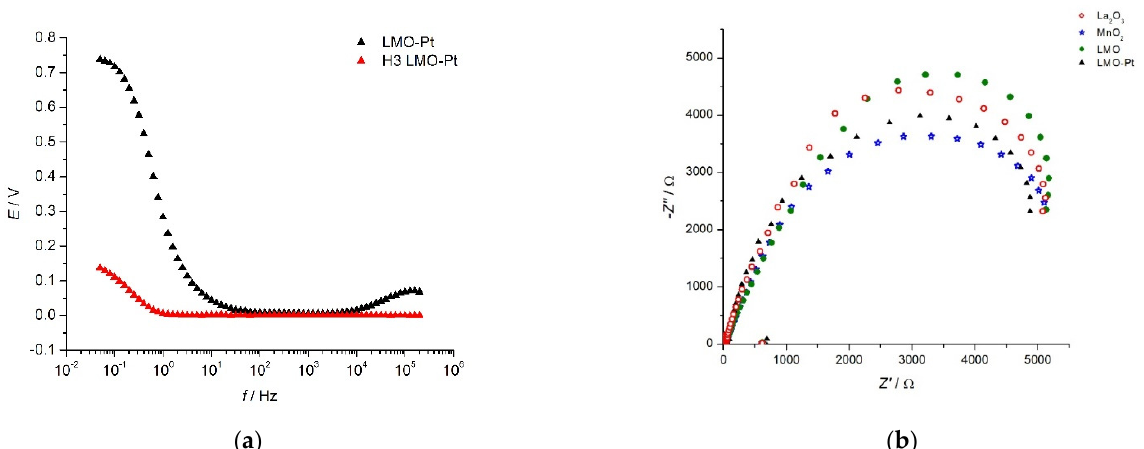
Figure 7. ( a ) First and third harmonic for LMO-Pt electrode material and ( b ) Adjusted Nyquist diagrams of La 2 O 3 , MnO 2 , LMO, and LMO-Pt electrolytic material in O 2 -saturated 0.10 M KOH at currents that correspond to OCP.